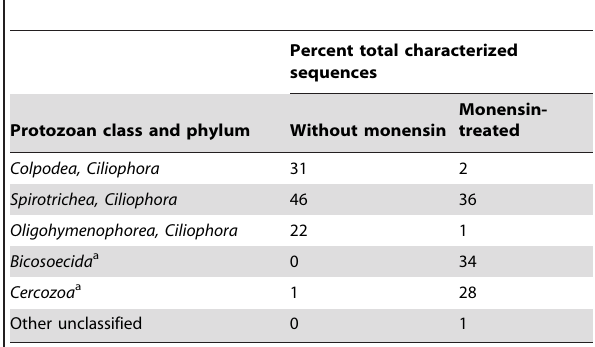
Table 2. Protozoa characterized from wastewater and wastewater treated with